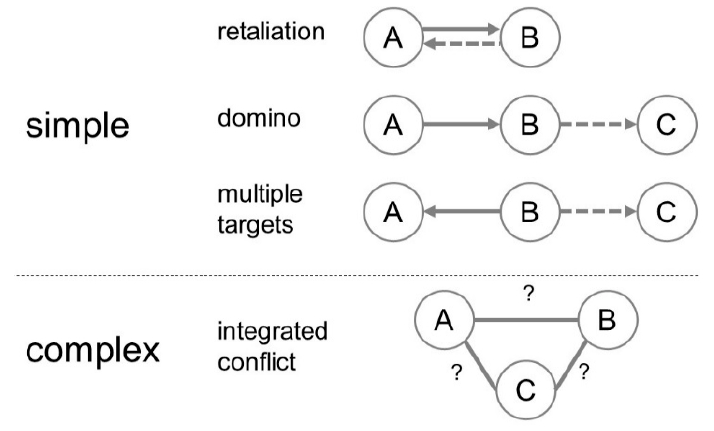
Figure 1. Structure of Violent Conflict.